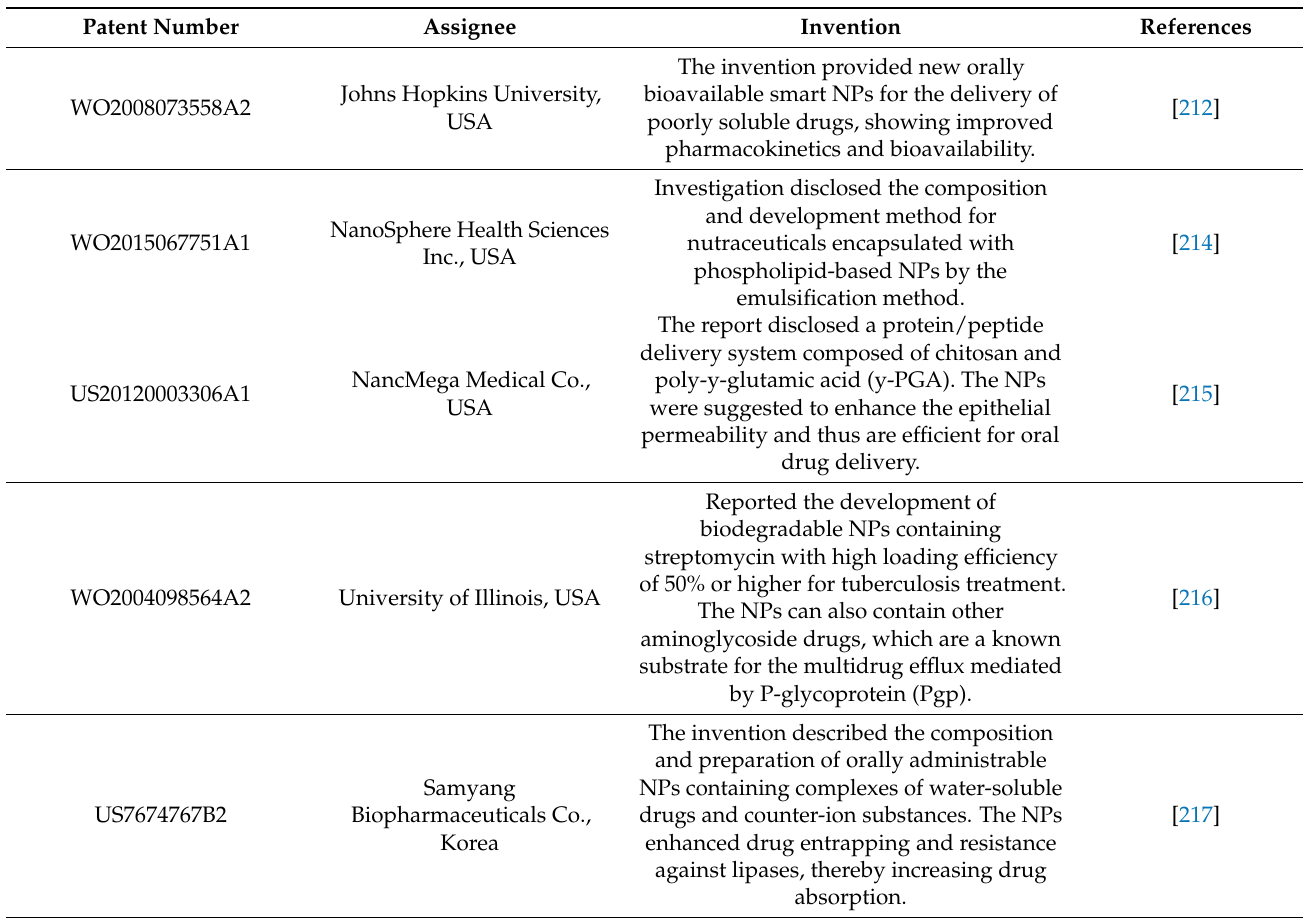
Table 11. List of patented formulations related to nanoparticles for oral drug